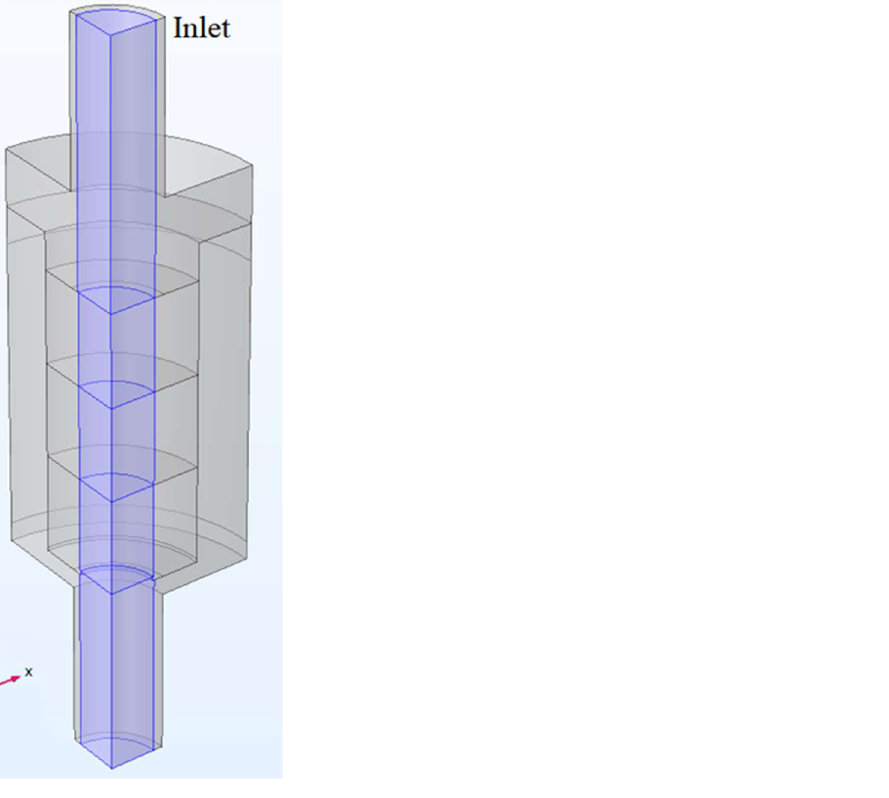
Figure 3. The schematic view of the 3D axisymmetric CFD model: a quarter of the experimental setup. Blue domains are inlet, stack of 3 filters and outlet respectively.